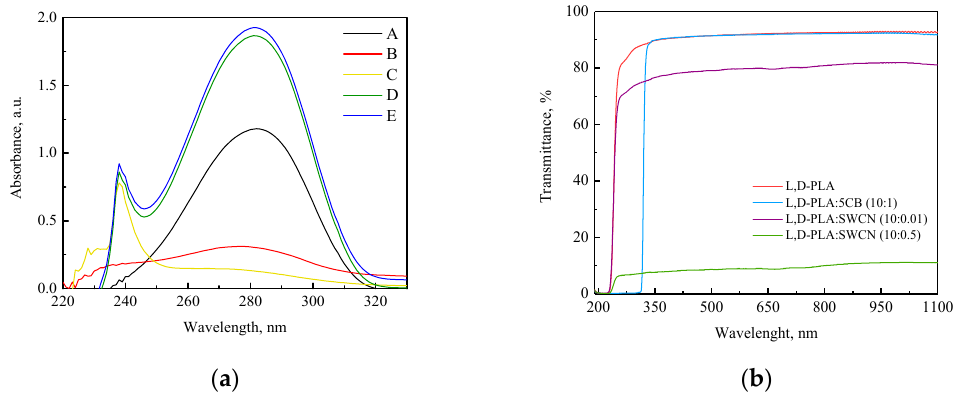
Figure 6. Absorption UV–Vis spectra of L,D-PLA and its compositions, 5CB and SWCN in chloroform with isosbestic points, where A—5CB; B—SWCN; C—L,D-PLA; D—L,D-PLA:5CB (930:1); E—L,D-PLA:5CB (930:1:3.8) ( a ) and the transmittance of L,D-PLA and its compositions ( b ).